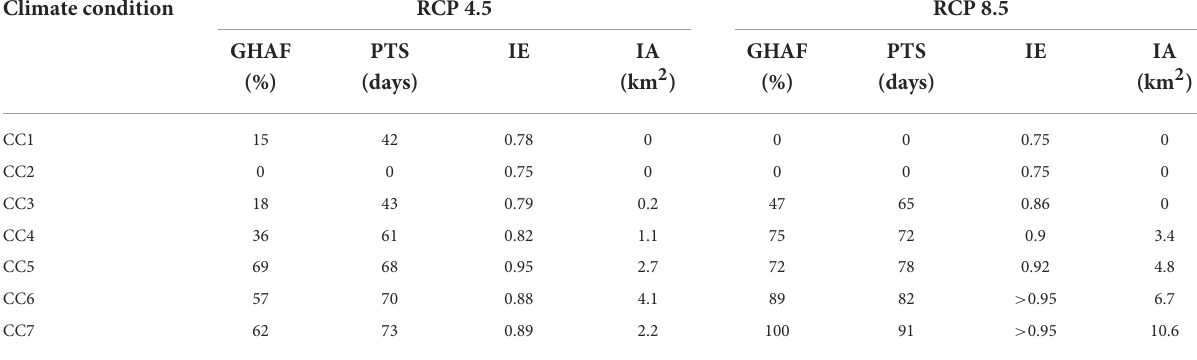
TABLE 5 The minimum management requirement for each method. Climate